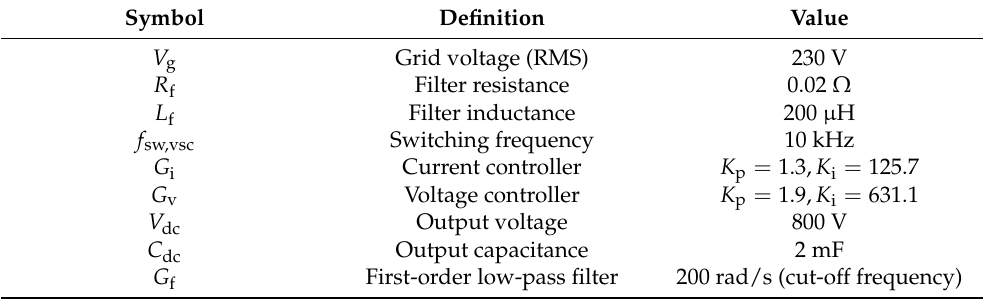
Table 1. Parameters of grid-forming VSC.